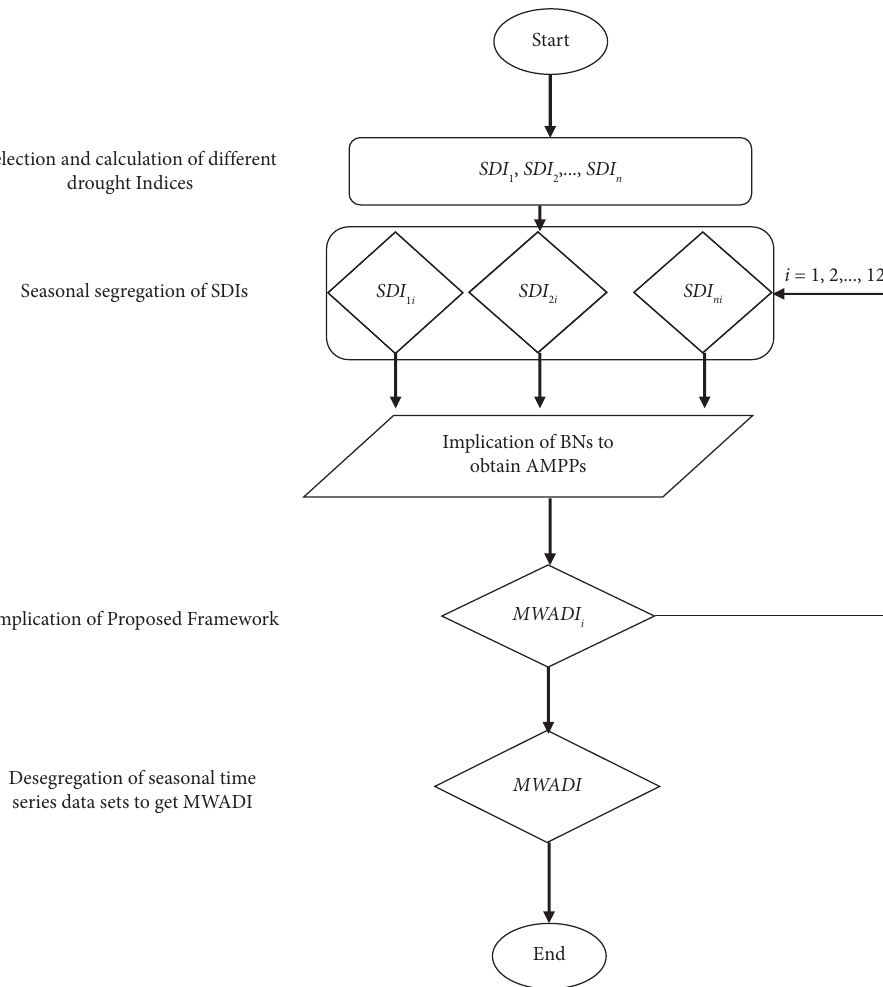
Figure 2: Graphical representation of the proposed